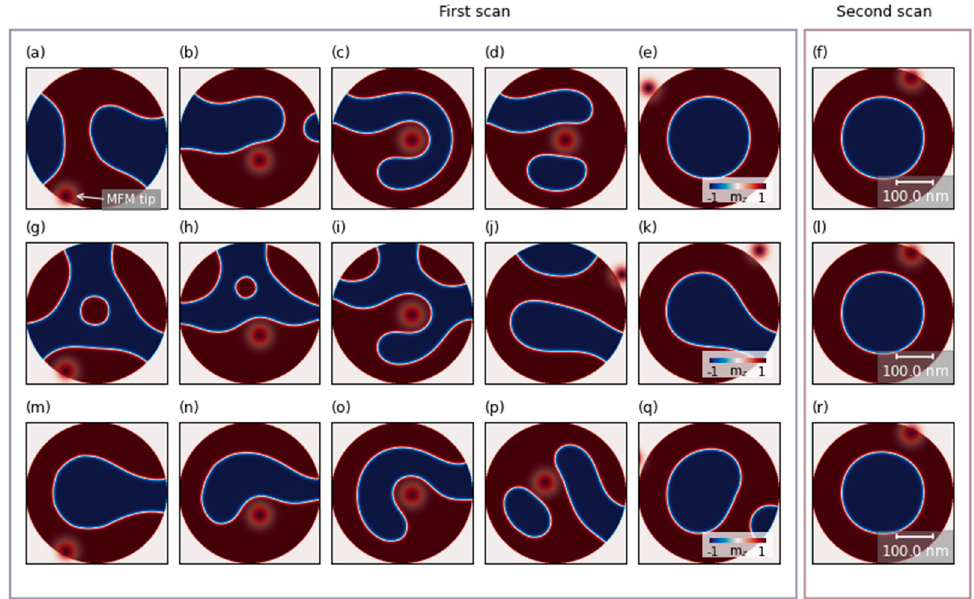
Figure 5. Simulated images of the magnetic configuration evolution to the skyrmion state ( a – e ), horseshoe state ( g – k ) and skyrmion and small domain state ( m – q ) depending on initial magnetization configuration ( a , g , m ). The right column of the left frame shows the simulated final state after the first scan. The right frame shows the simulation result after the second scan of the previous final state ( f , l , r ). The red circle represents the z-component of the magnetic field induced by the high-momentum tip. The red and blue colors correspond to the positive and negative out-of-plane components of the magnetization,